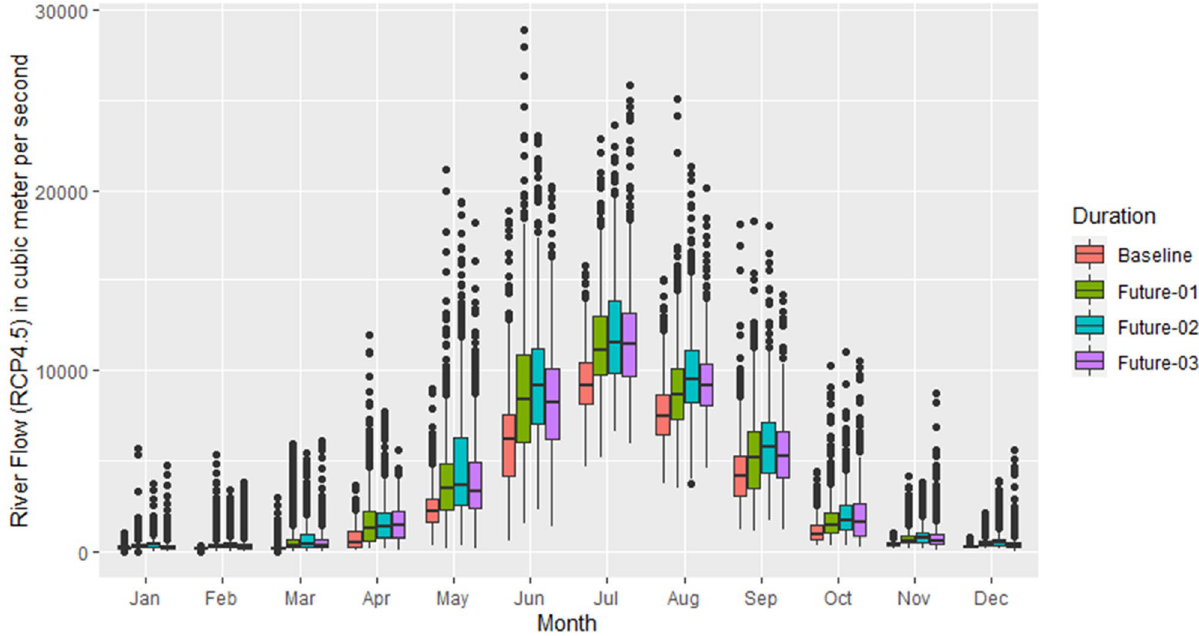
Figure 6. Monthly comparison of daily reiver flow in future with the baseline (1976–2005) under the RCP4.5. On x-axis, moths are mentioned while on y-axis, river flow is presented in cubic meter per second. The future durations are: Future-01 = 2011–2040, Future-02 = 2041–2070, Future-03 = 2071–2100.